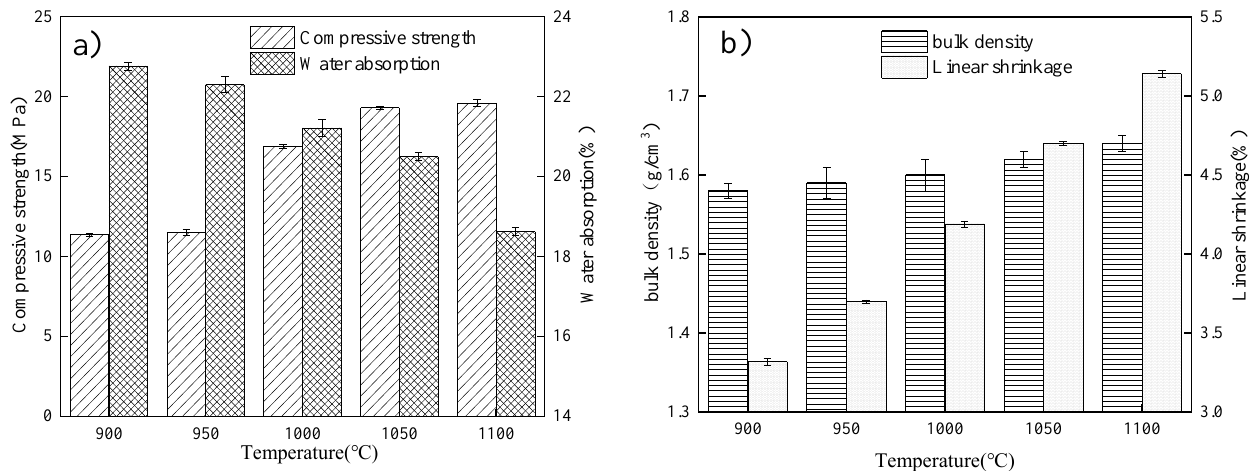
Figure 9. Effect of sintering temperature on the characteristics of sintered brick: ( a ) compressive strength and water absorption; ( b ) bulk density and sintering shrinkage.